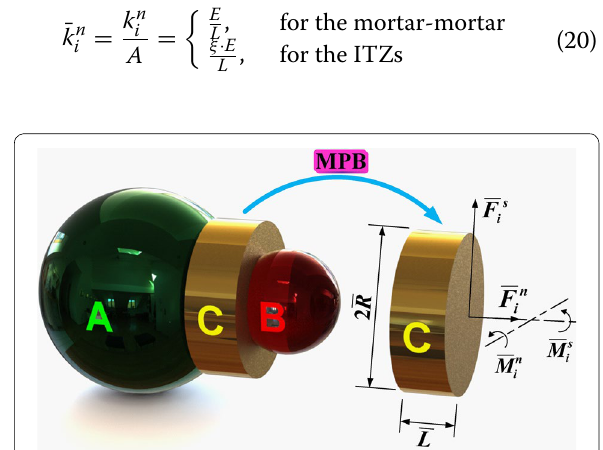
Fig. 6 The MPB depicted as a circular-section